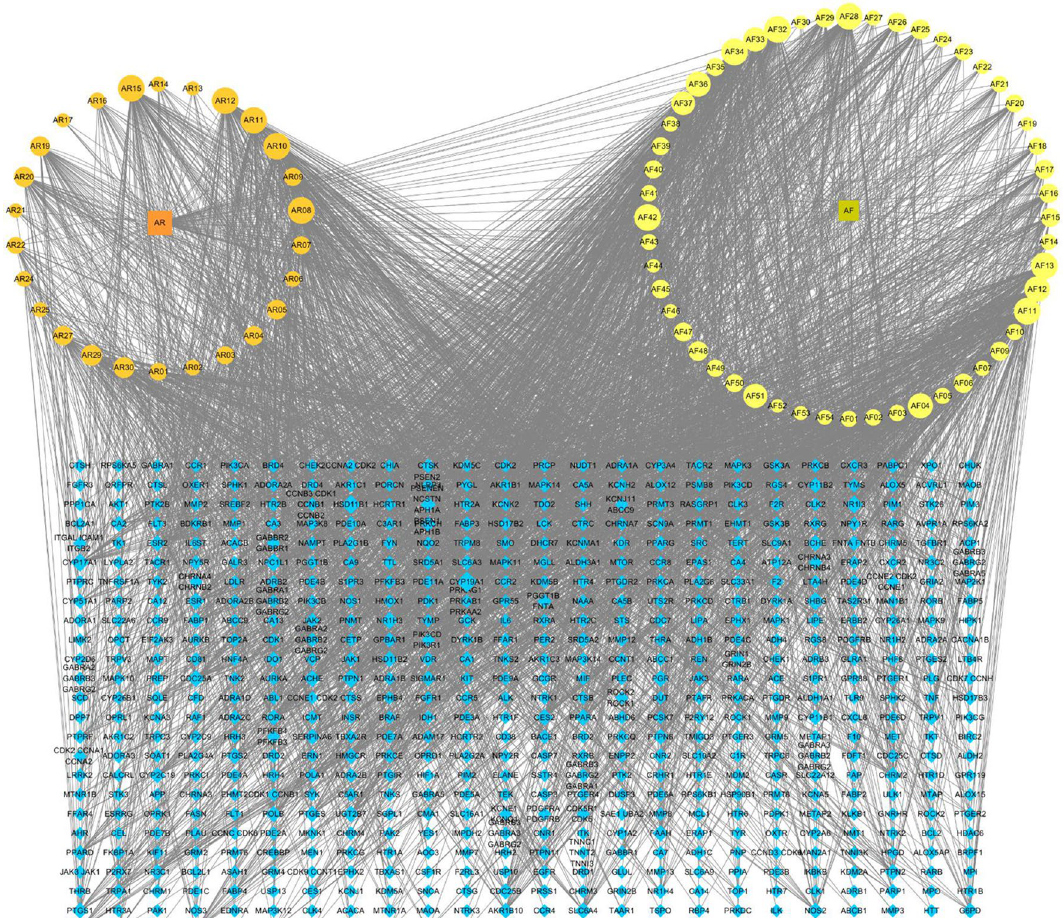
Figure 2. Compound-target network. Orange circle nodes represent the main components of AR, and yellow circle nodes represent the main components of AF. Blue rhombus nodes represent the targets of pound targets as well as the potential pharmacological effects of AR-AF were visually illustrated. We identified 12,202, 3168 and 472 GC-related targets from GeneCards, DisGeNET and OMIM, respectively, which resulted in 12,844 targets after merging and removing duplicate targets (Fig. 3A). A total of 482 target genes were identi- fied to be affected by GC and regulated by AR-AF, which are more critical to treat GC (Fig. 3B).